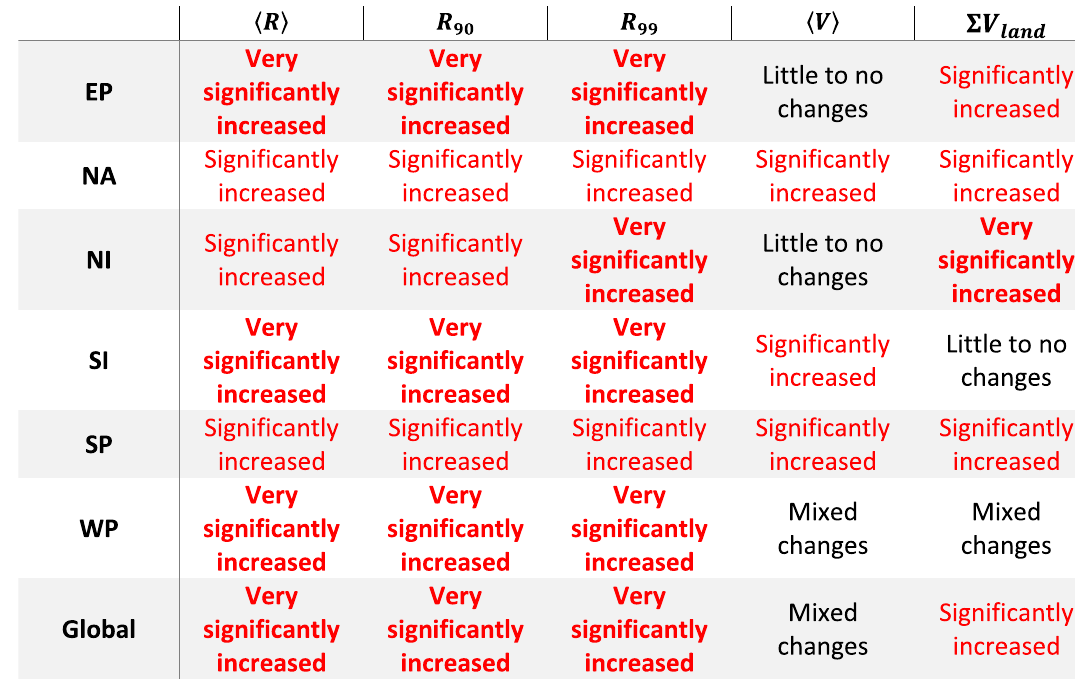
Table 5. Summary of TC precipitation trends relating to precipitation rate percentile and volume totals across basins and at the global scale. Red text shows trends where at least 2 of 4 intensity classifications